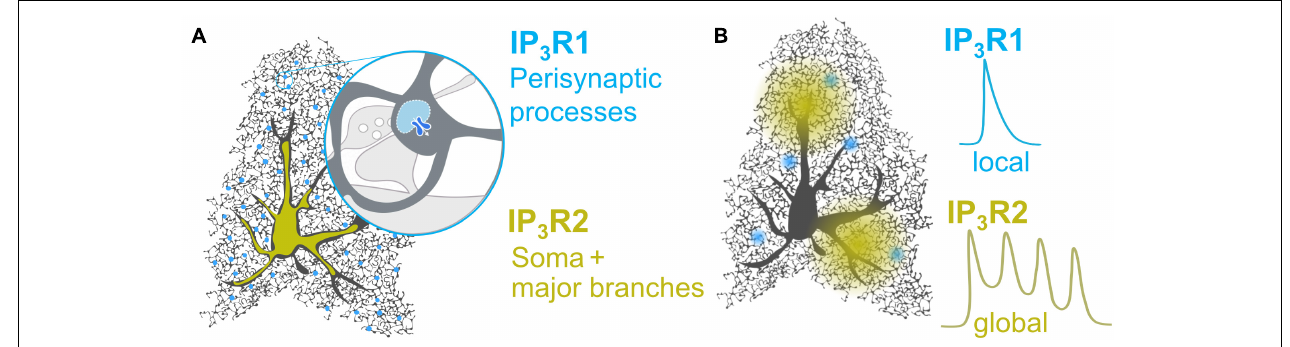
FIGURE 1 | Proposed distribution and Ca 2 + profiles of IP 3 R1 and IP 3 R2 in astrocytes. (A) While IP 3 R2 is distributed in the soma and major branches (Takata et al., 2011; Chen et al., 2012; Petravicz et al., 2014), IP 3 R1 may be enriched in the peri-synaptic processes (Sherwood et al., 2017; Takano et al., 2020), for instance in the nodes which were recently shown to host 2-APB-sensitive local Ca 2 + signals at the tripartite synapse (Arizono et al., 2020). (B) IP 3 R2 generates global Ca 2 + waves and oscillations in both astrocytes (Srinivasan et al., 2015; Sherwood et al., 2017) and model cells (Miyakawa, 1999). IP 3 R1 mediated Ca 2 + dynamics in astrocytes have not been observed directly, but may resemble IP 3 R1-dependent monophasic Ca 2 + transients observed in model cells (Miyakawa, 1999) and dendritic spines of pyramidal neurons (Holbro et al.,